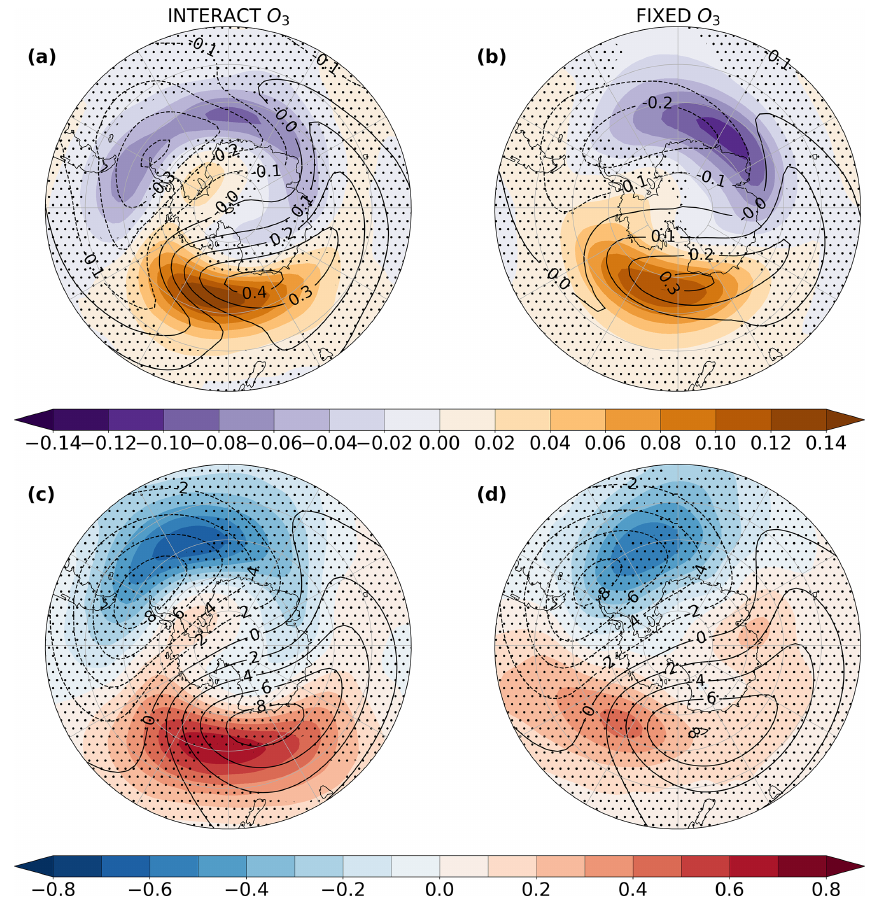
Figure 8. Polar stereographic maps of the October 70hPa trends in INTERACT O 3 (a, c) and FIXED O 3 (b, d) ozone ( a, b ; ppmv per decade) and temperature ( c, d ; K per decade) anomalies from the zonal mean for the period 1958–2002 (color shading). Stippling masks regions where the trends are not significant at the 95% confidence level. The overlaying contours show the corresponding October